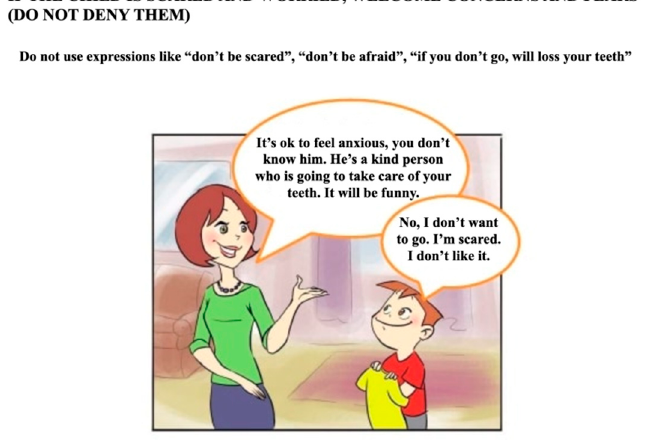
Figure 2. Example of easy-to-understand language and colorful images adopted.